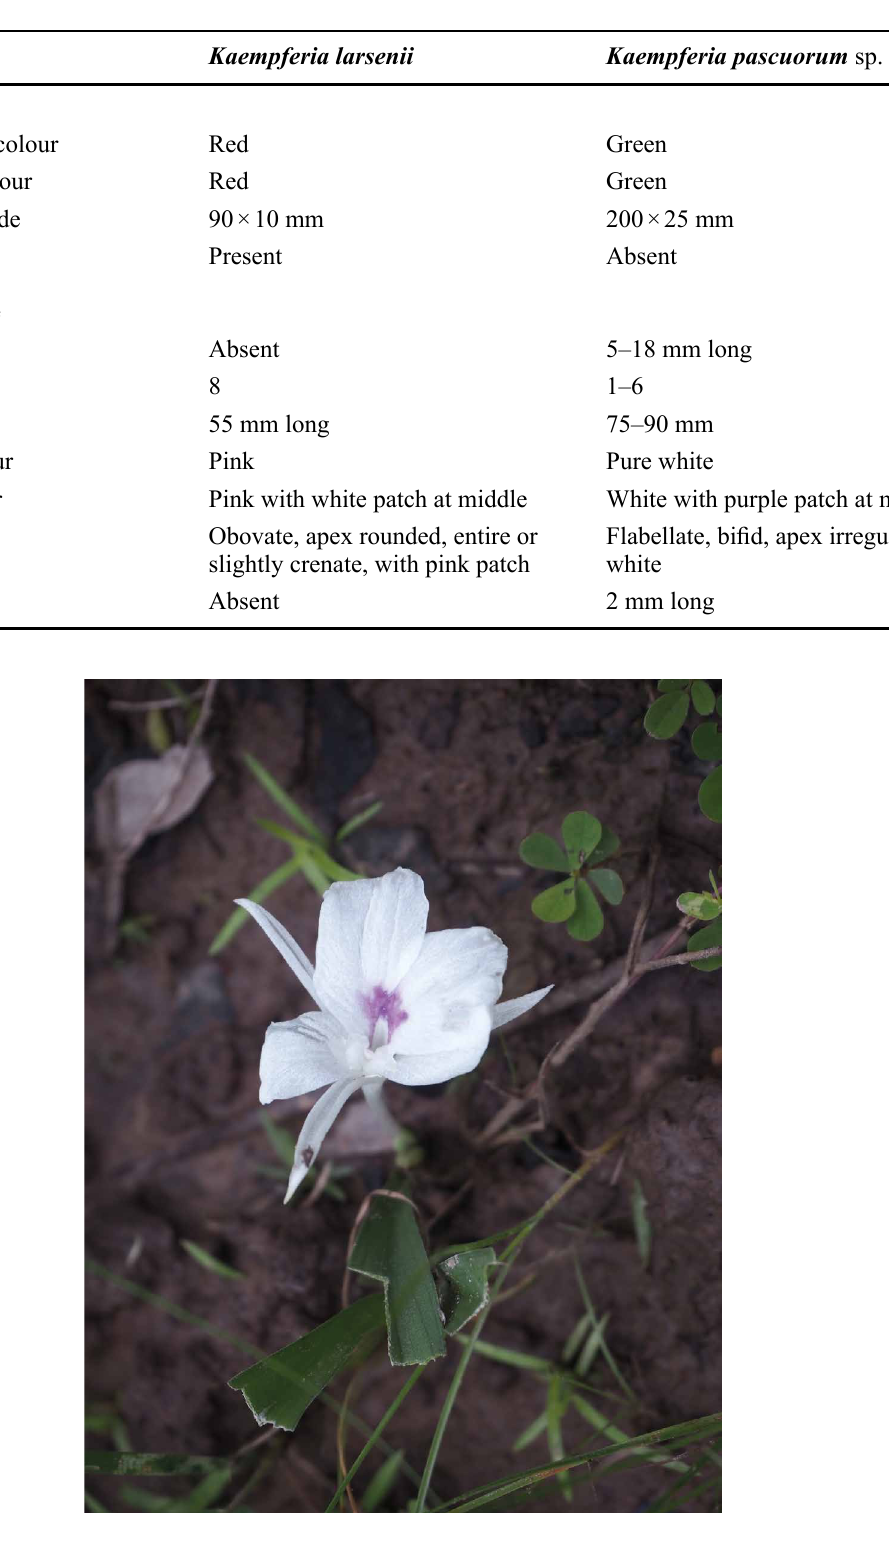
Table 3. Morphological comparison of Kaempferia larsenii Sirirugsa and Kaempferia pascuorum Insis. sp.